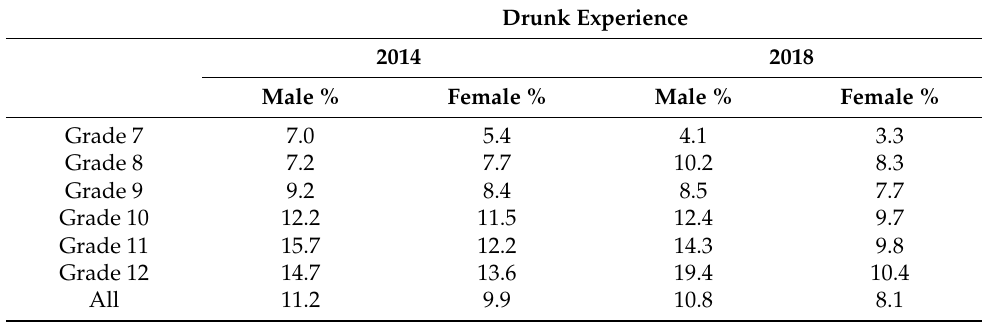
Table A3. Past 12-month drunk experience by gender and grade in 2014 and